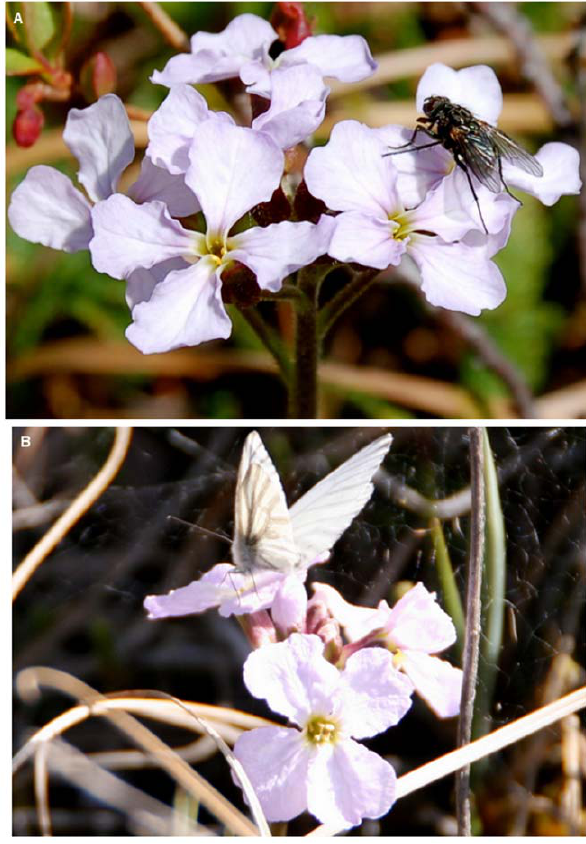
Figure 2. Floral visitors. 2A. Muscid fly and 2B. Pieris angelika visiting Parrya nudicaulis .